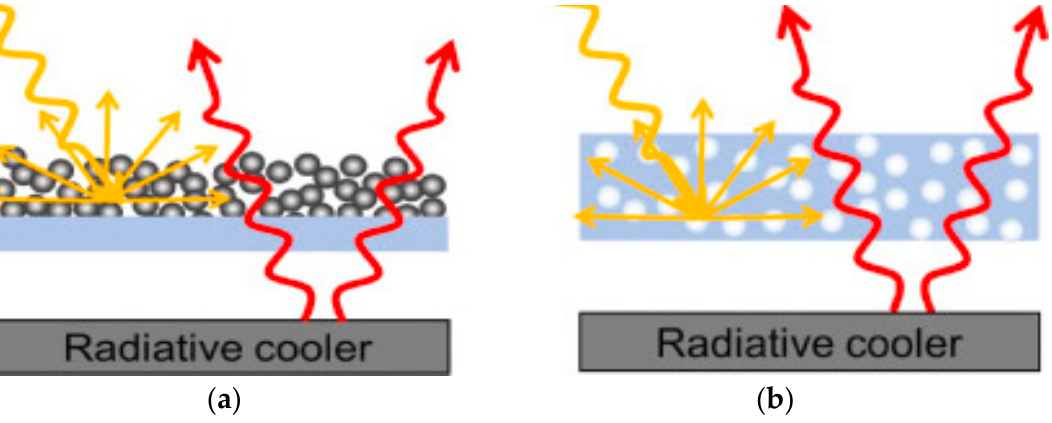
Figure 35. Schematic representation of ( a ) nanoparticle coating cover shields and ( b ) nanoporous PE cover shields [42].